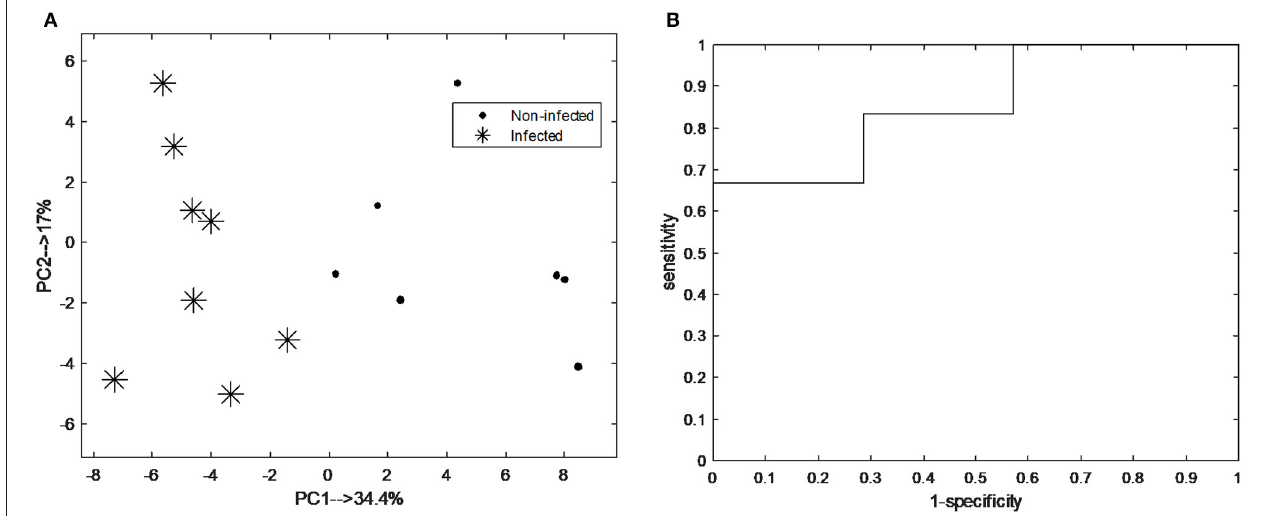
FIGURE 4 | (A) Principal component analysis (PCA) score plot score plot obtained from breathogram belonging to pre-infection (i.e., baseline; asterisk) and post-infection (T5-6; black dot) using a set of 15 discriminatory VOCs; (B) Receiver operating characteristic curve (ROC) of the independent test samples of the final random forest (RF) model obtained pre-infection and post-infection samples using the set of 15 discriminatory VOCs. The area under the curve is 0.93.